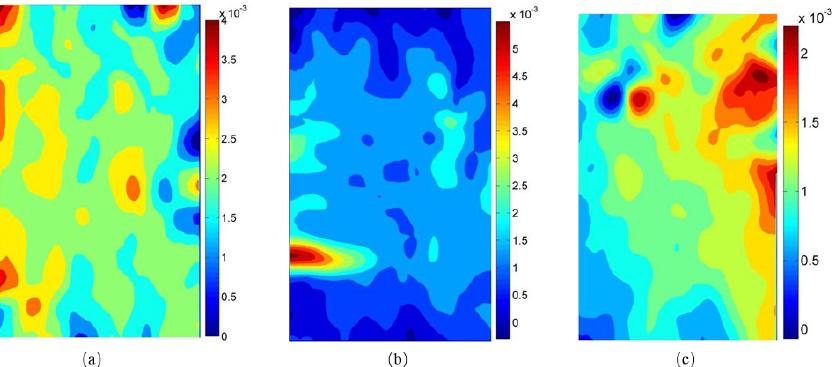
Figure 12. Cloud map of the maximum principal strain distribution before the failure of the shale specimen without cracks: ( a ) ε 1 distribution before splitter destruction (S0), ( b ) ε 1 distribution before arrester destruction (A0), and ( c ) ε 1 distribution before divider destruction (D0). Table 3. The critical strain value of shale failure measured by the non-cracked compression test. Loading and Bedding